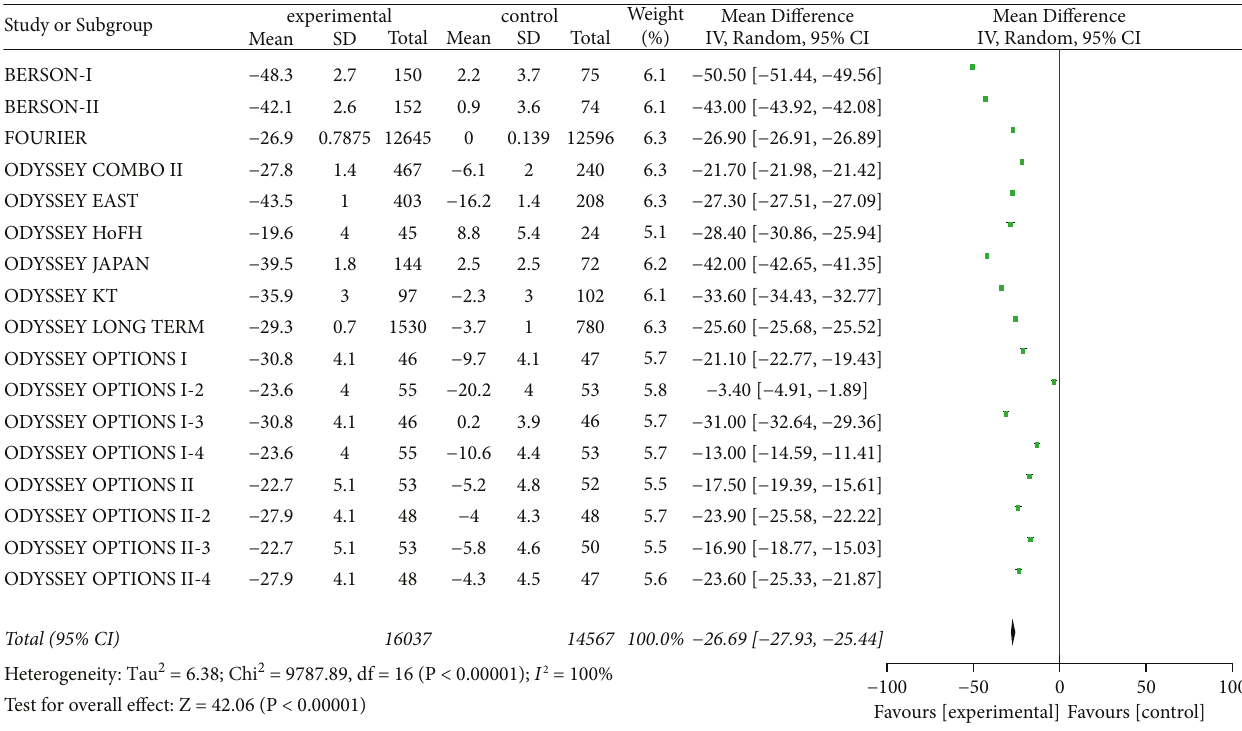
Figure 7: Comparison of the reduction of serum Lp (a) (%) from baseline between control group and experimental